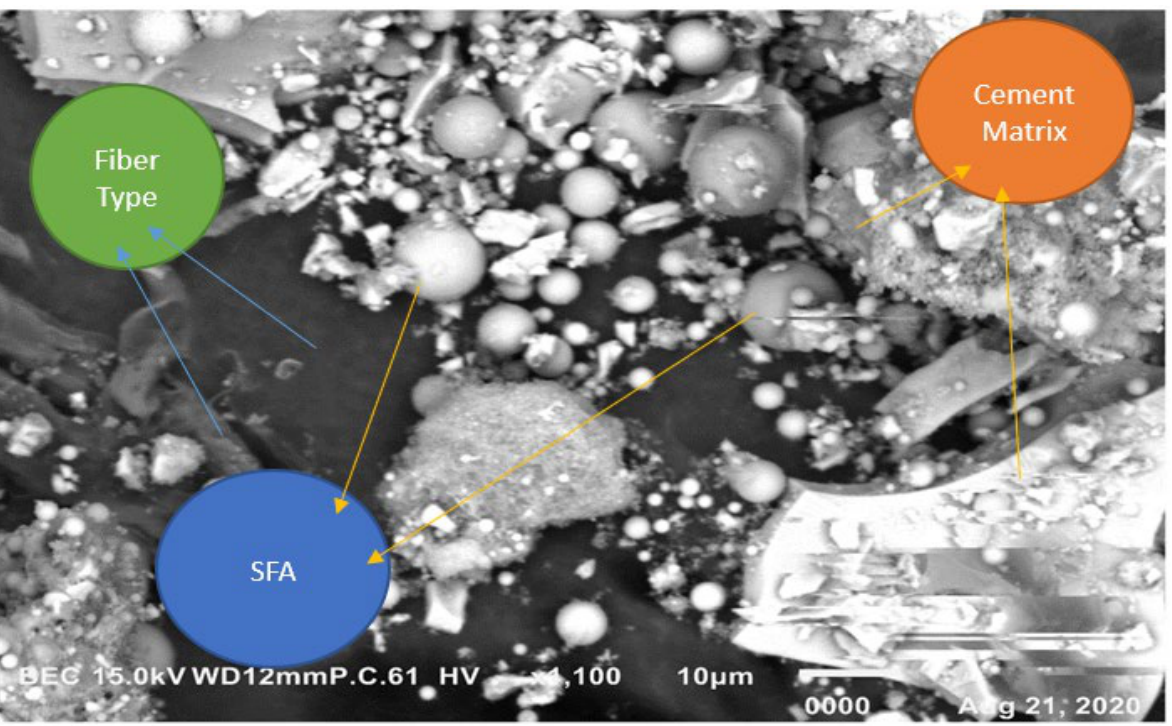
Figure 15. SEM image—EDS mapping on a 10 µm scale.